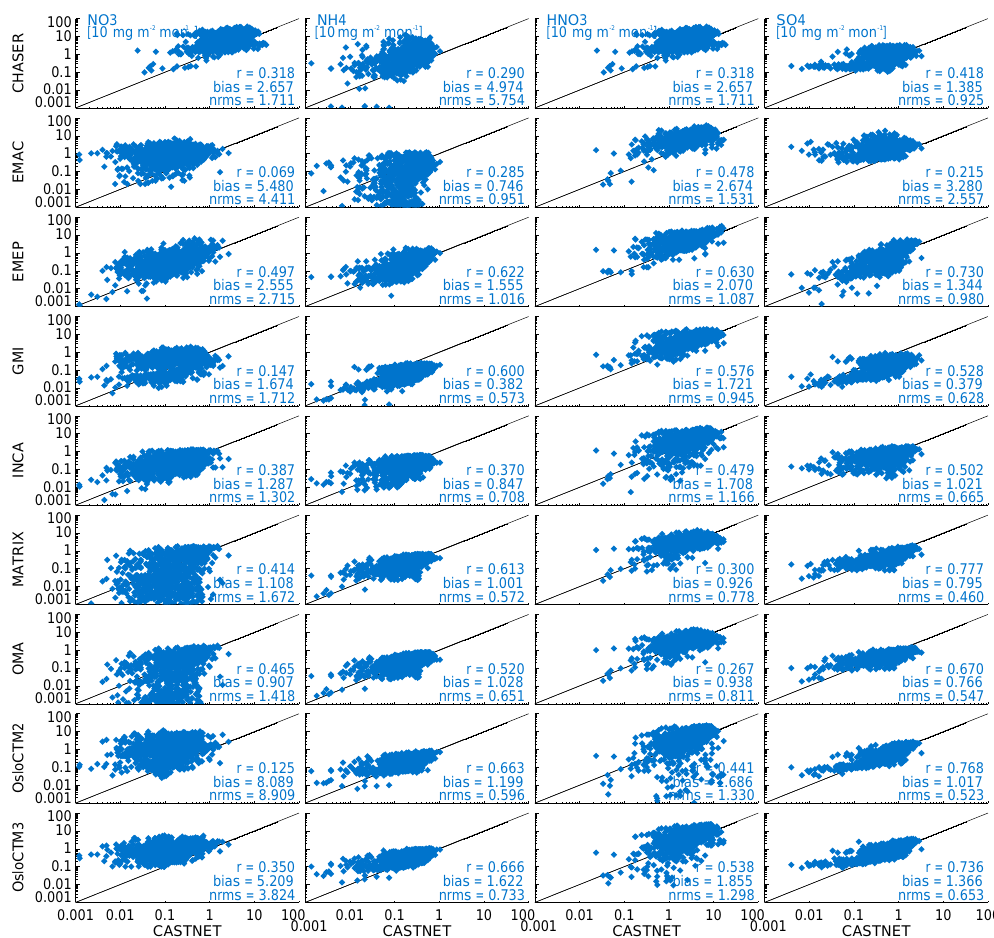
Figure 6. Comparison of surface dry deposition of NO − 10mgm − 2 mon − 1